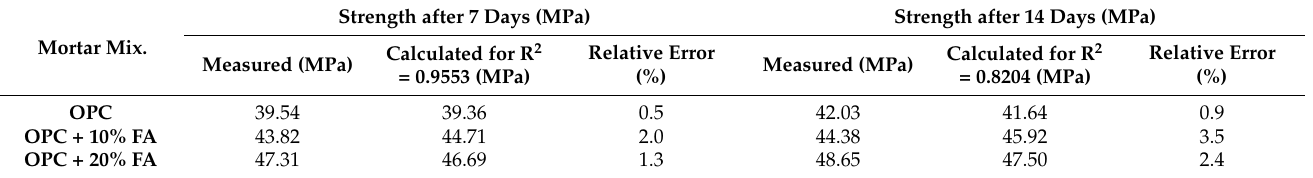
Table 7. Comparison of strength of mortar cured at 53 ◦